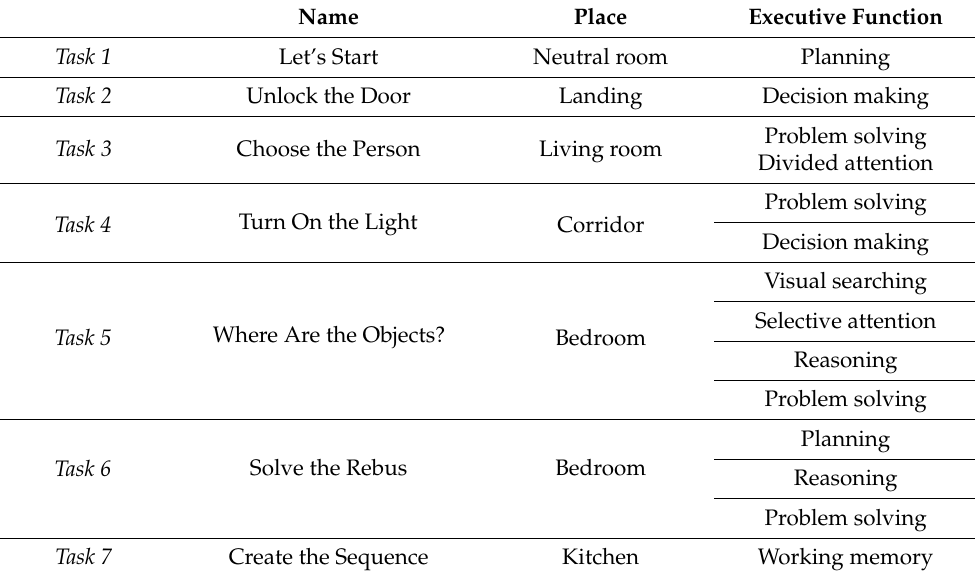
Table 2. Subtasks and related